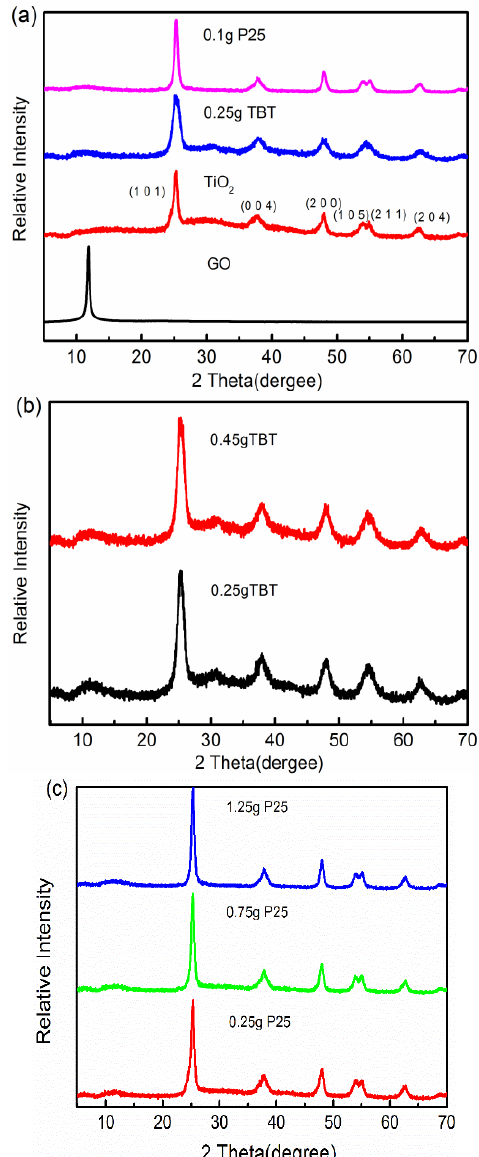
Figure 1. ( a )X-ray powder diffraction (XRD) patterns of 0.1 g P25, 0.25 g TBT, TiO 2 , and graphene oxide (GO); ( b ) XRD patterns of the weights of different TBT added in TiO 2 /rGO